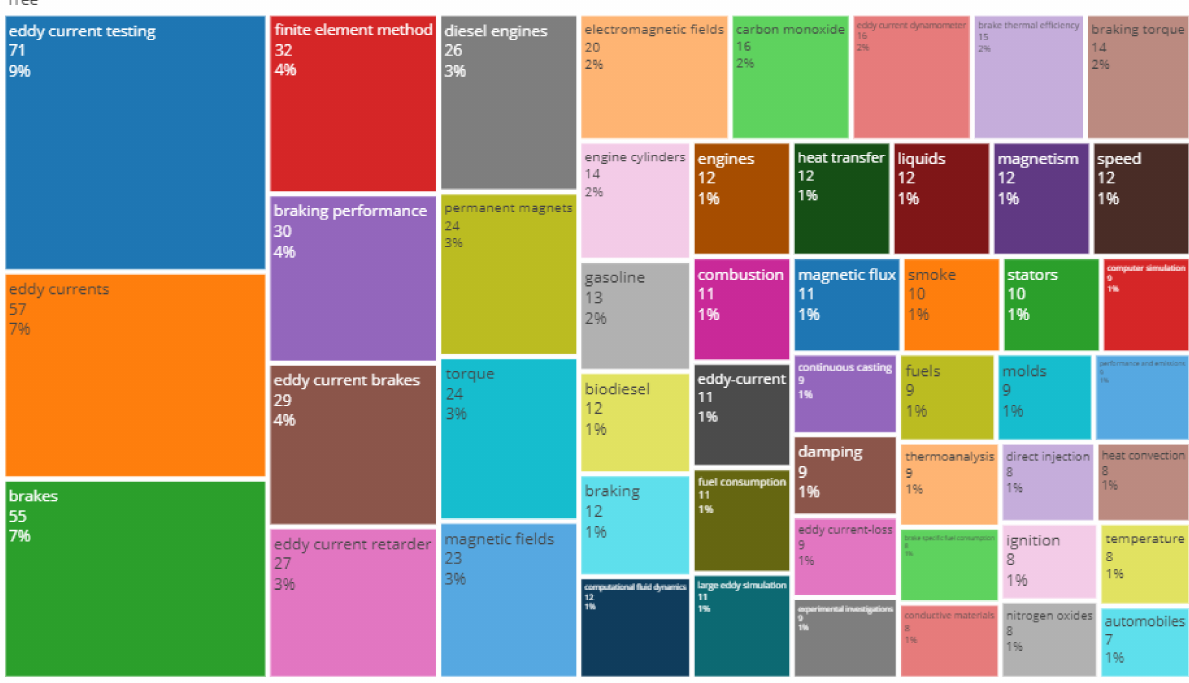
Figure 11. Treemap analysis (Field: Keywords